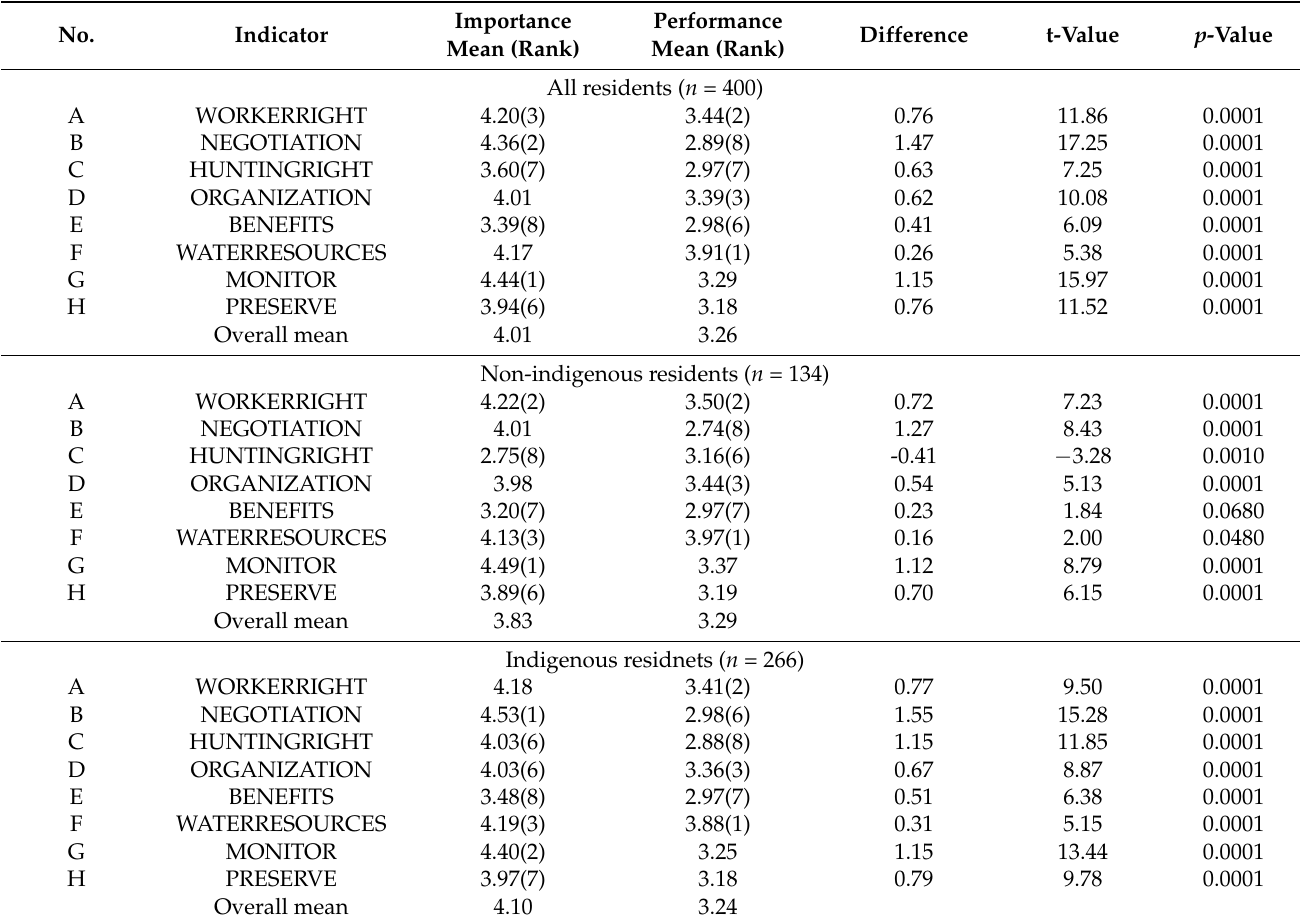
Table 3. Mean scores and paired-sample t -test among residents for the SFM indicators on importance and performance levels.